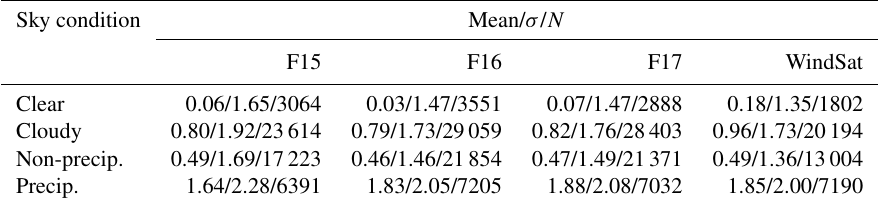
Table 2. Mean and standard deviation of differences (MW minus RO) in TPW (mm) between four MW radiometers and COSMIC RO under various sky conditions. The sample numbers for each pair are shown in the third position of each column. Sky condition Mean/ σ / N